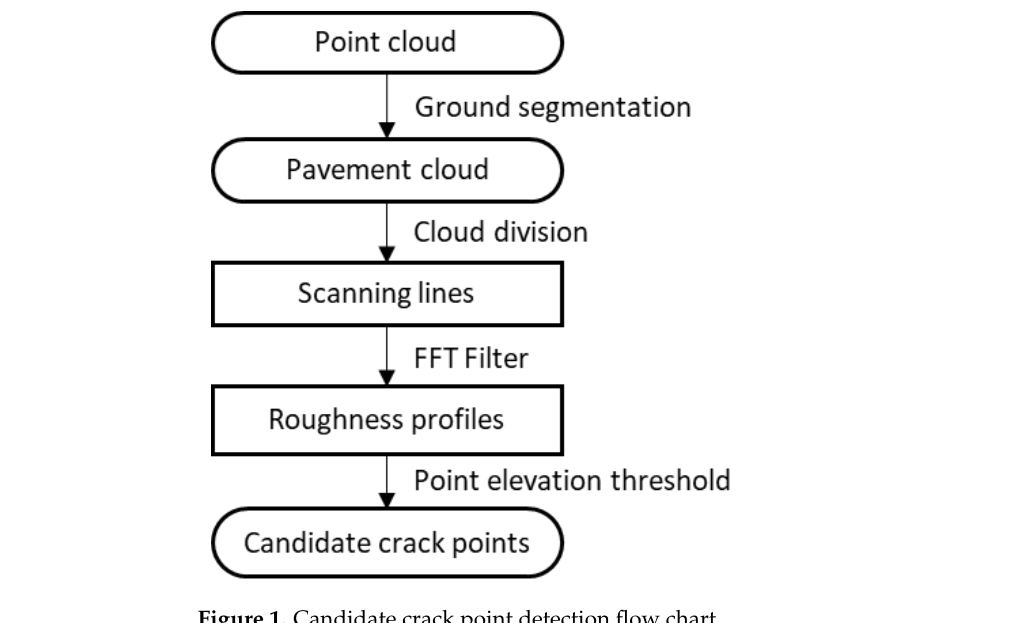
Figure 1. Candidate crack point detection flow chart.